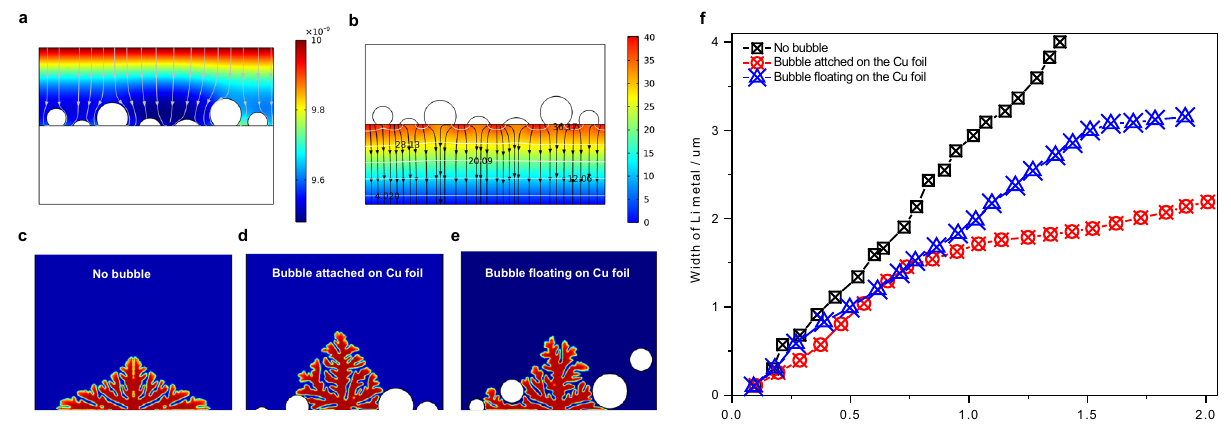
Fig. 3 | Gas effects on the Li metal deposition. The simulation of the distribution of( a )Li + concentrationand( b )electric fi eldwithbubblesattachedtothesurfaceof coppersurface.Thebubble-effectsonthemorphologicalevolutionofdepositedLi